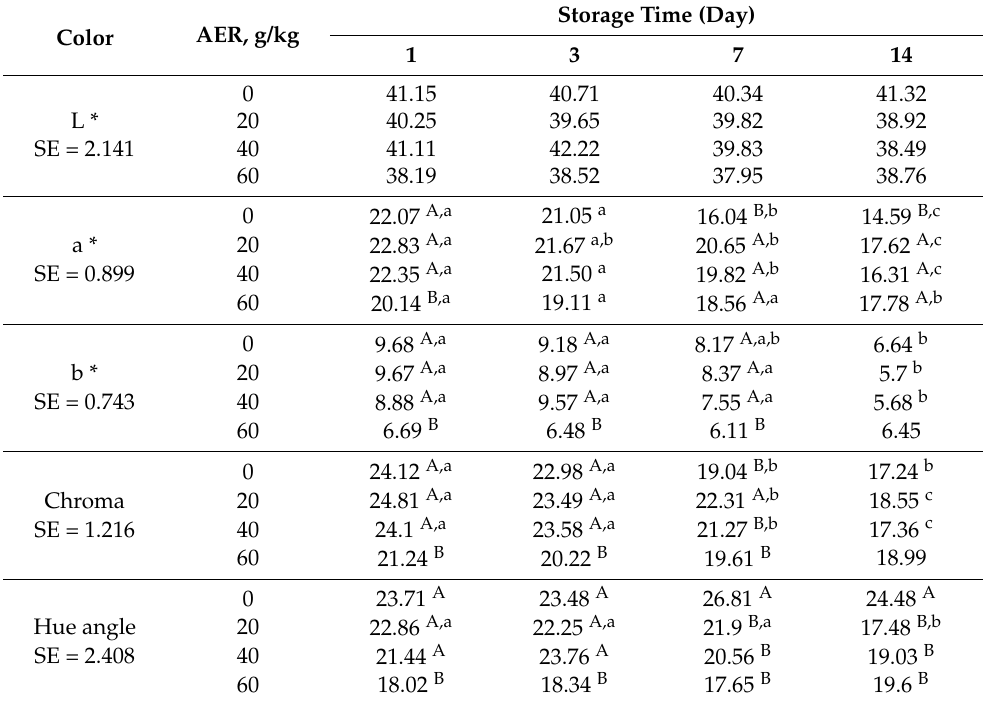
Table 2. Color of Longissimus dorsi (LD) from male dairy cattle with AER in TMR diets at different storage time. AER,